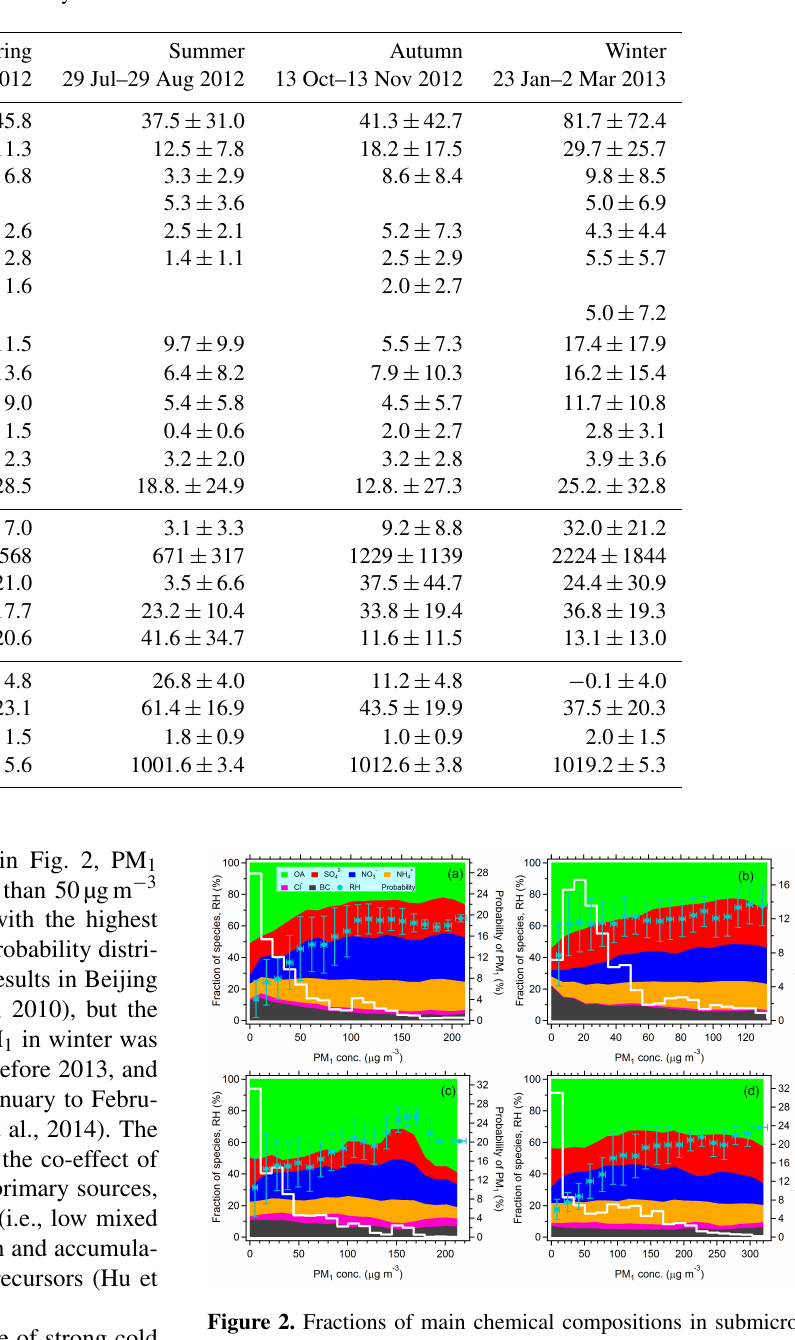
Table 1. Seasonal variations in main chemical components in PM 1 and gaseous pollutants, and meteorological conditions (temperature, T ; relative humidity, RH; wind speed, WS; pressure, P ). The data are listed in the form of “average ± standard deviation”. Units of particulate and gaseous pollutants are ppbv and µgm − 3 , respectively.